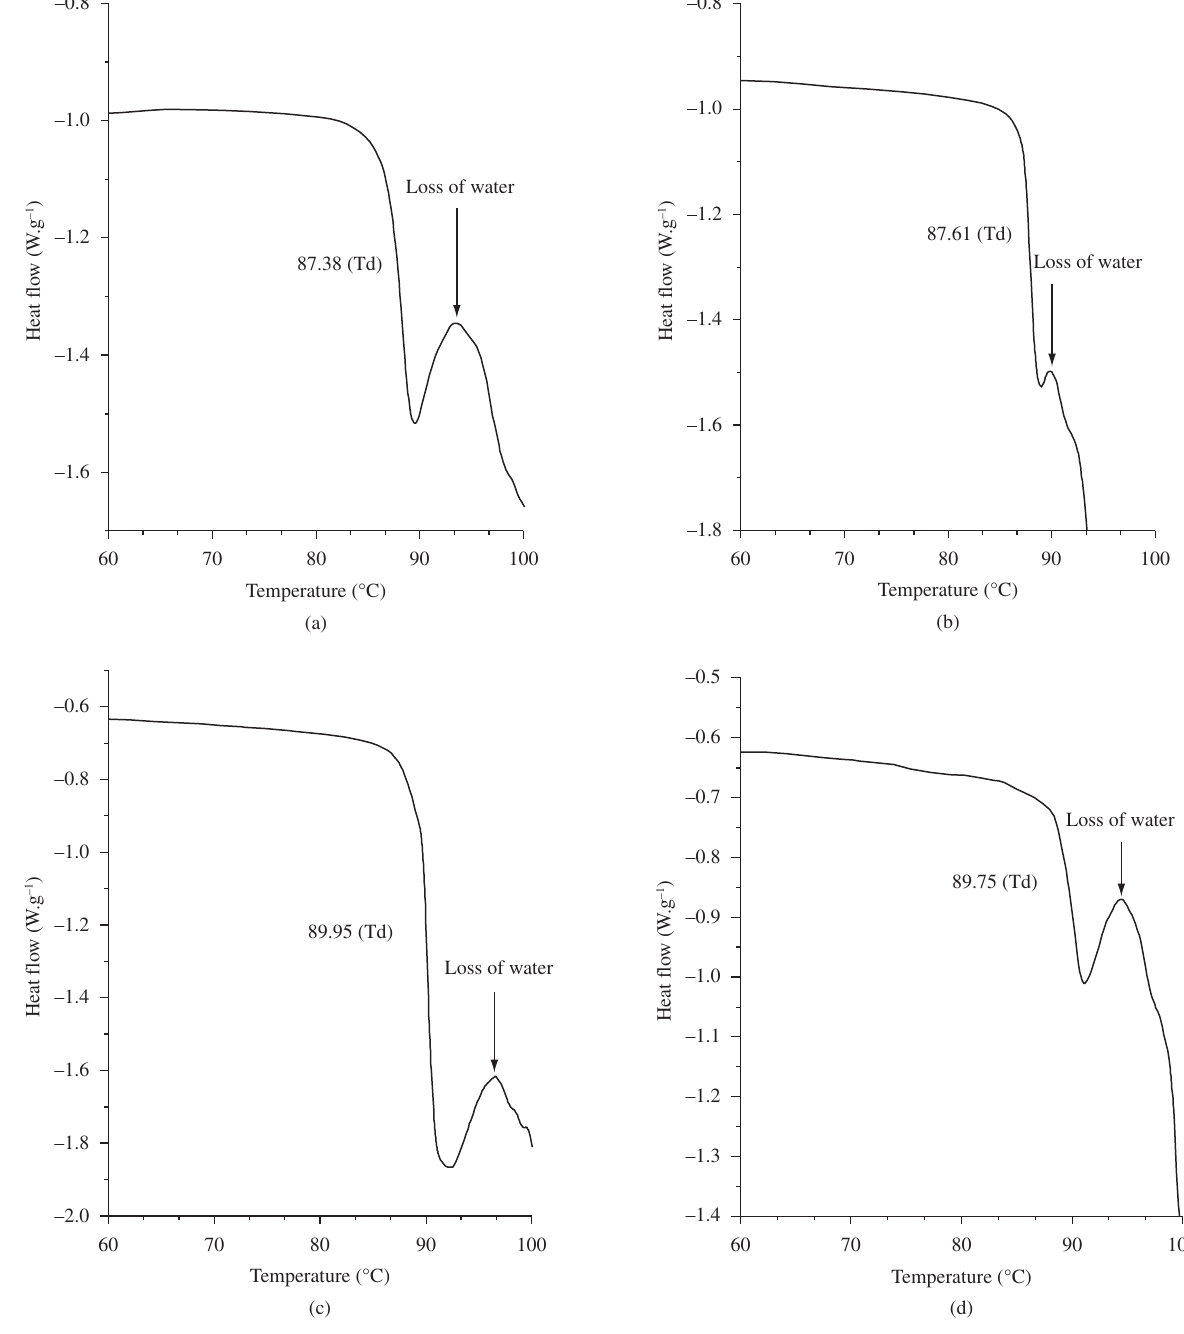
Figure 1. Thermogram of bovine pericardium materials after crosslinking with glutaraldehyde (GA) under different conditions: a) 0.5% GA for 10 days; b) 0.5% GA for 10 days followed by glutamic acid/borate buffer; c) Pre-treatment with GA 0.05% + 0.5% GA for 10; d) Pre-treatment with GA 0.05% + 0.5% GA for 10 days followed by glutamic acid/borate